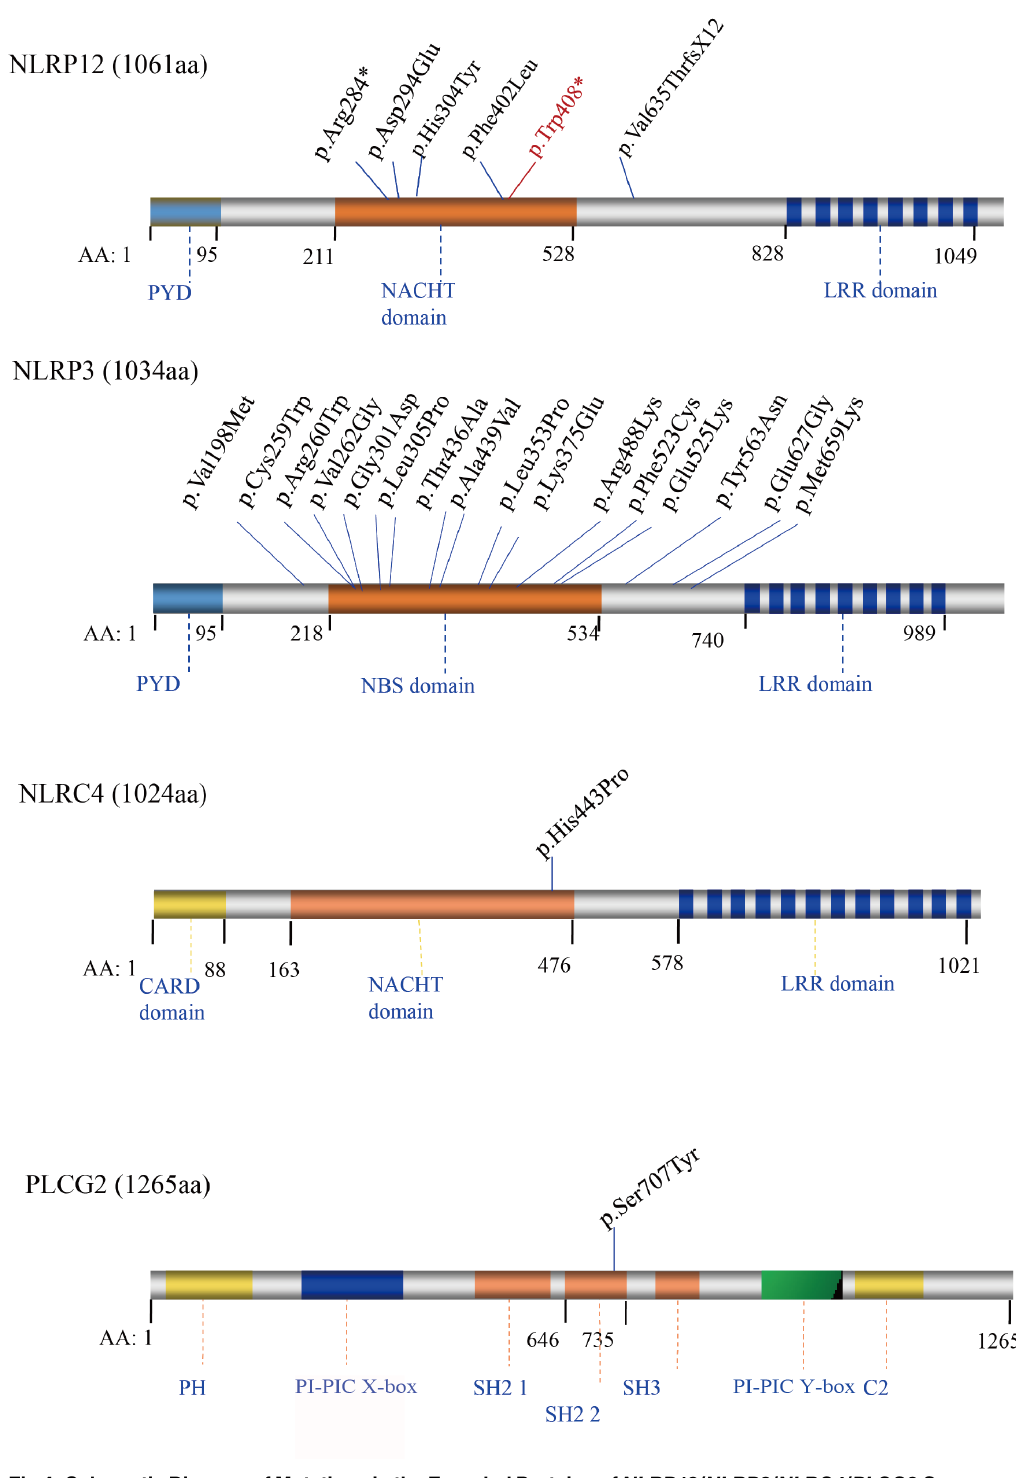
Fig 4. Schematic Diagram of Mutations in the Encoded Proteins of NLRP12/NLRP3/NLRC4/PLCG2 Genes Associated with FCAS. Rectangles with different colors indicate specific protein domains. The solid blue line indicates the position of the reported mutation, and the solid red line shows the p.Trp408 * mutation related to our study.